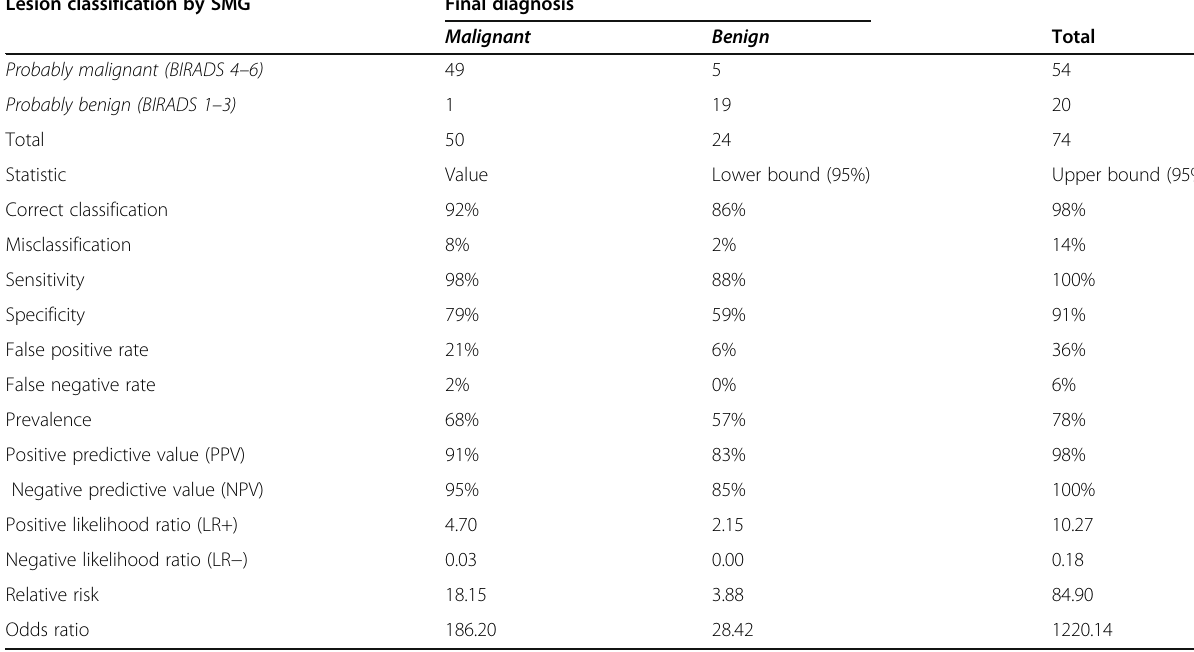
Table 9 Diagnostic accuracy of CESM tested in patients with ACR grade C/D versus the result of biopsy or follow-up as the gold standard for lesion